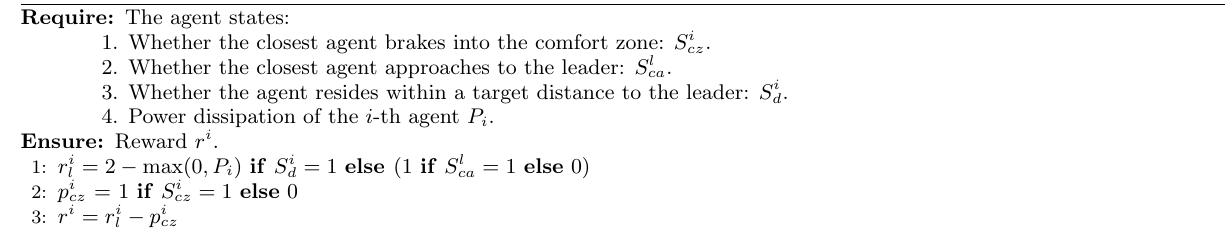
Algorithm 3 Reward: The locomotion efficiency